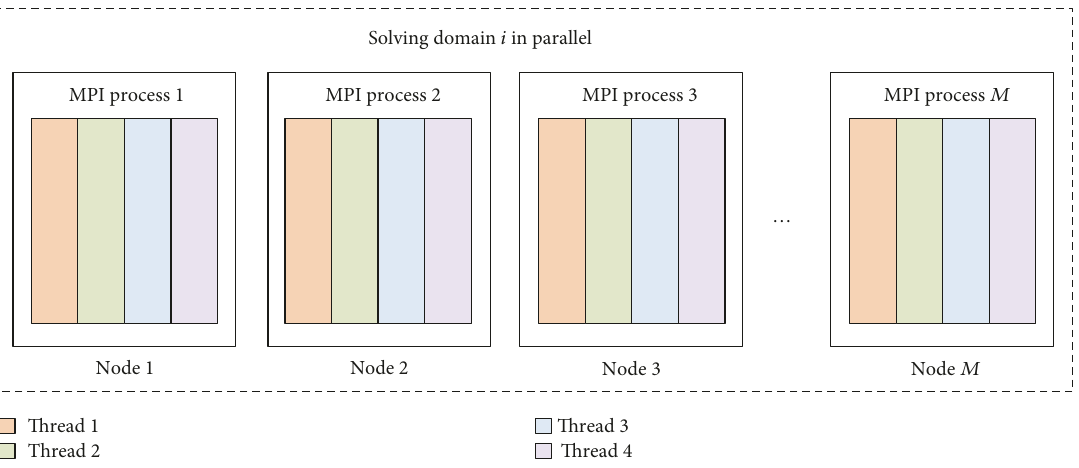
Figure 3: Workload distribution of MPI/OpenMP strategy.